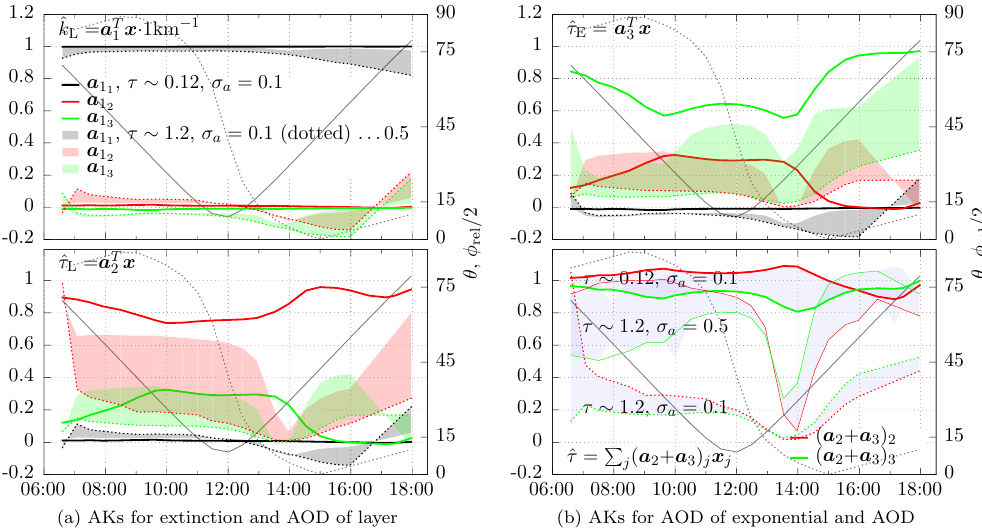
Fig. 9. (a) and ( b ), top panel: row vectors a i of the averaging kernel (AK) matrix for the regularised least-squares retrieval of x =( k L · 1km, τ L , τ E ) T as in Fig. 8. For the ground layer profile with τ ∼ 0.12 (bold lines) only the regularisation parameter σ a =0.1 is shown. For τ ∼ 1.2 the range of parameters σ a =0.1 ... 0.5 is indicated by the shaded areas. (b) (bottom panel) illustrates how well the AOD τ = τ L + τ E can in principle be reconstructed. Ideally, the contributions from τ L (red) and τ E (green) should be equally